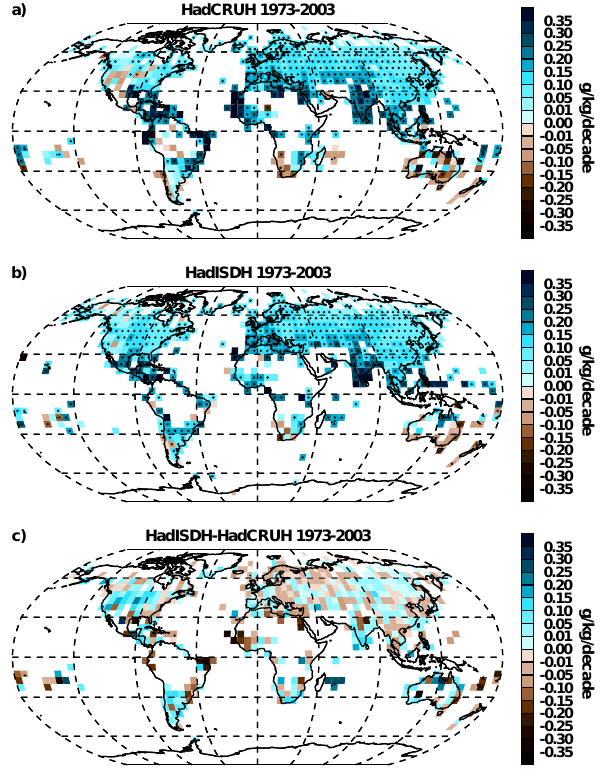
Fig. 9. Decadal trends in specific humidity for HadCRUH versus HadISDH over the 1973–2003 period of record. Trends have been estimated using the median of pairwise slopes (Sen, 1968; Lan- zante, 1996) method. Where intervals defined by the 95% confi- dence limits on the median of the slopes are both of the same sign as the median trend presented in the grid boxes, the trend is pre- sumed to be significantly different from a zero trend. This is indi- cated by a black dot within the grid box. This means that there is higher confidence in the direction of the trend, but not necessar- ily the magnitude. The spread of the confidence interval provides the confidence in the magnitude; these values are available online at www.metoffice.gov.uk/hadobs/hadisdh. Note non-linear colour